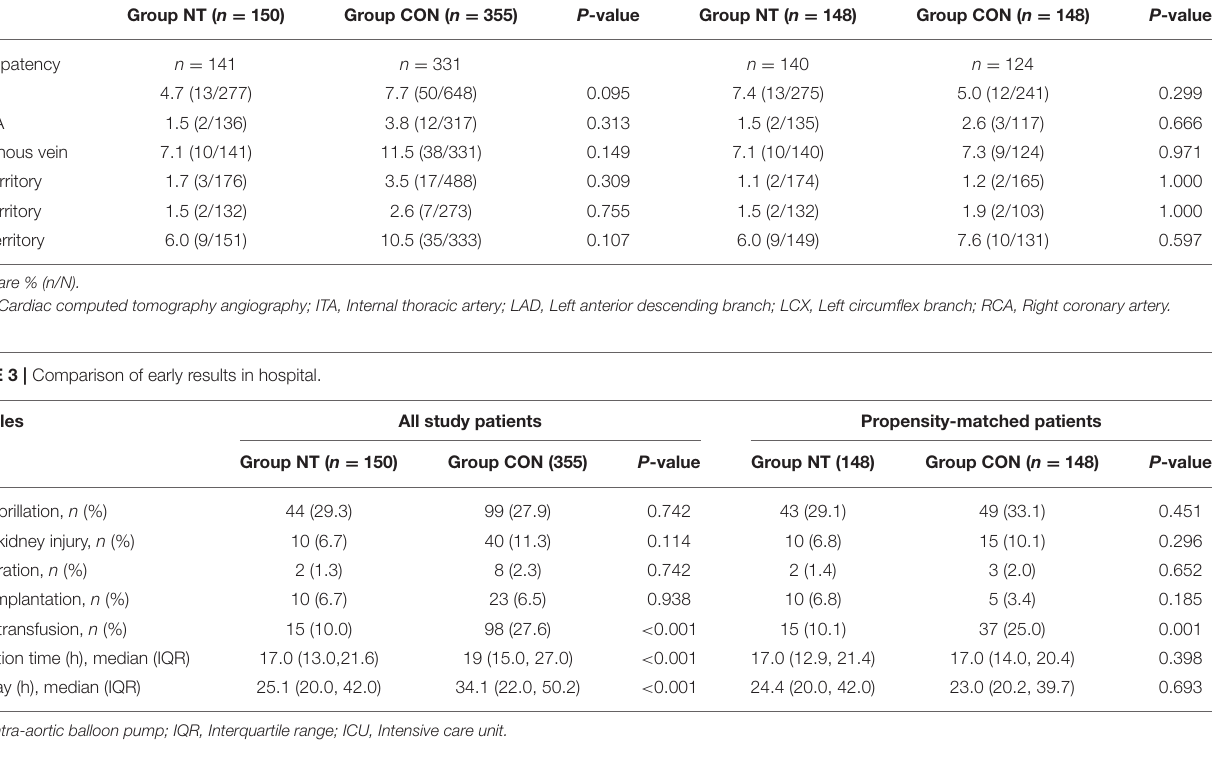
TABLE 2 | 1-year CCTA patency rates of the grafts and the coronary artery territories. All study patients Propensity-matched patients